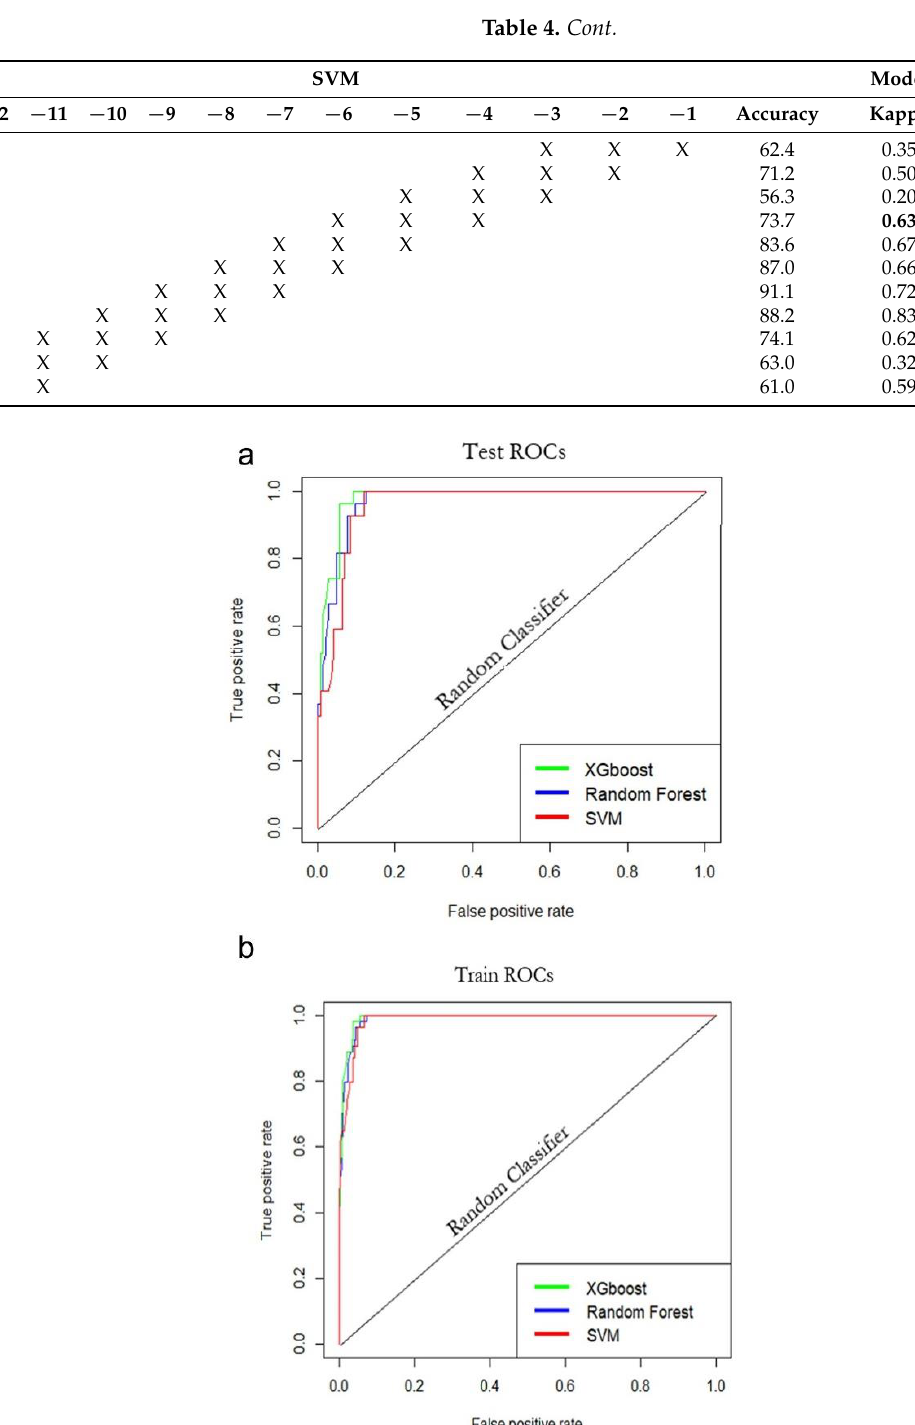
Figure 4. Machine Learning models ROCs for Test ROC (a) and Train ROC (b).